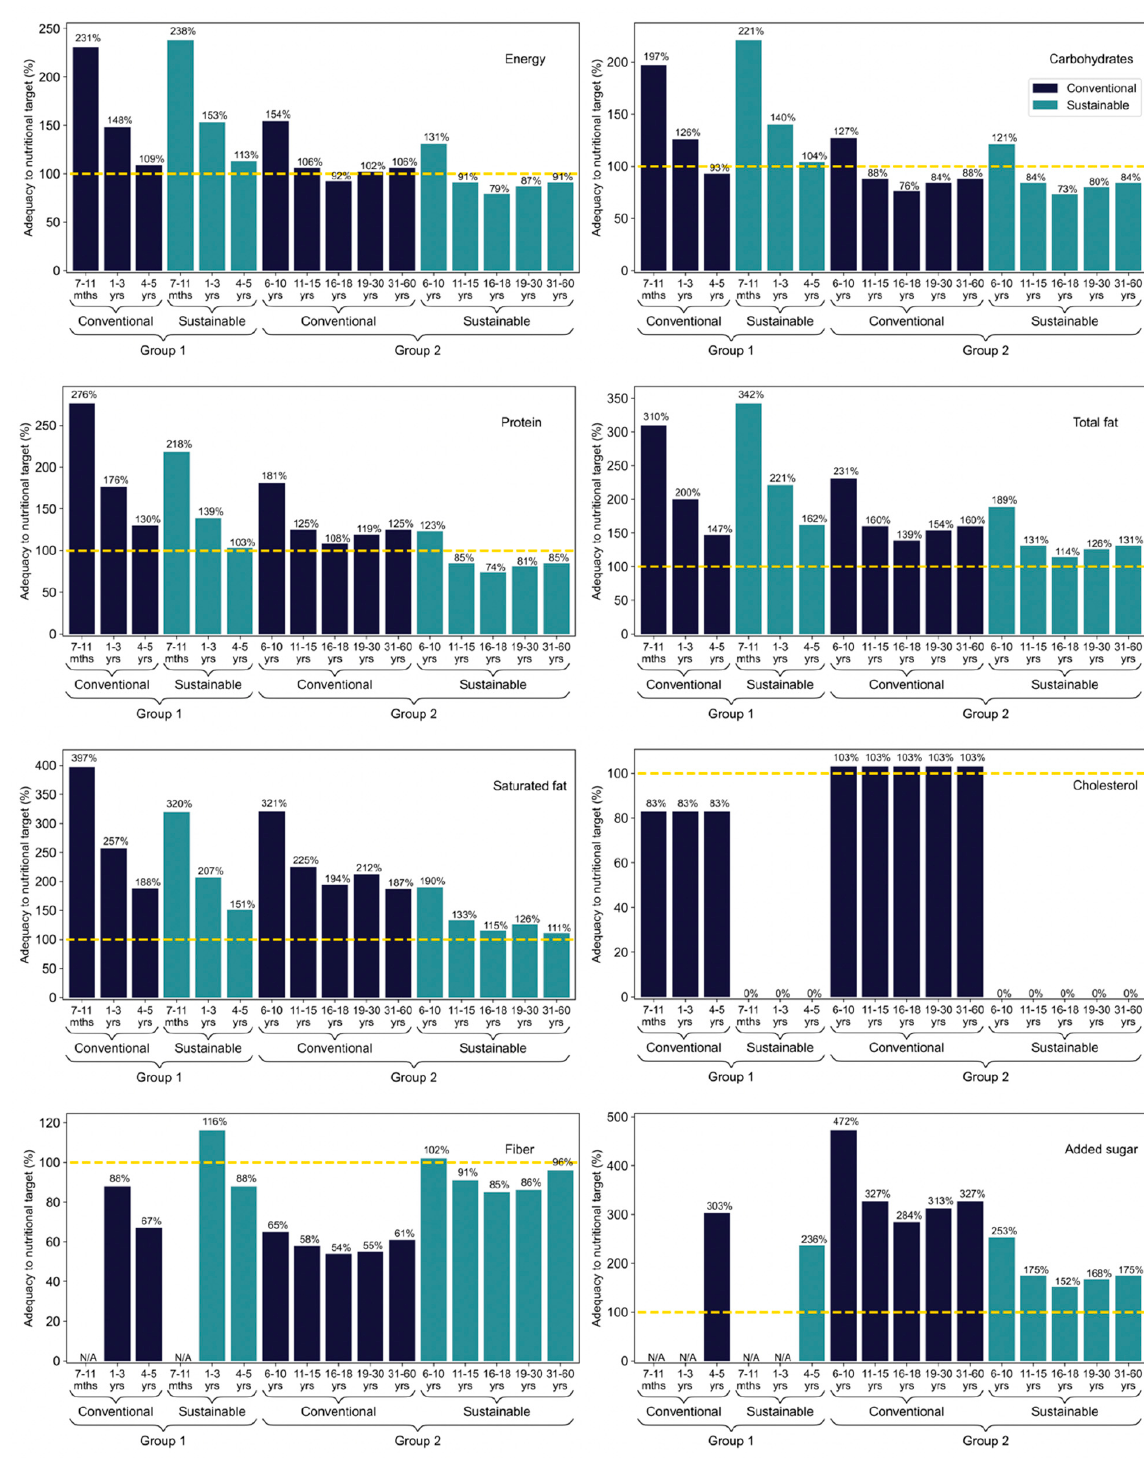
Figure 2. Macronutrient adequacy of conventional and sustainable menus to nutritional targets, according to the age group. Age groups considered were from 7 months to 60 years old, for both school food menus. Yellow dashed line represents the national daily nutritional recommendation for school meals (Group 1 is 70%, and Group 2 is 30% of the daily intake). For saturated fat, cholesterol, and added sugar, the daily nutritional recommendation refers to a maximum level. N/A means no official recommendations for this age group. Mths and yrs on the X axis mean months and years, respectively.